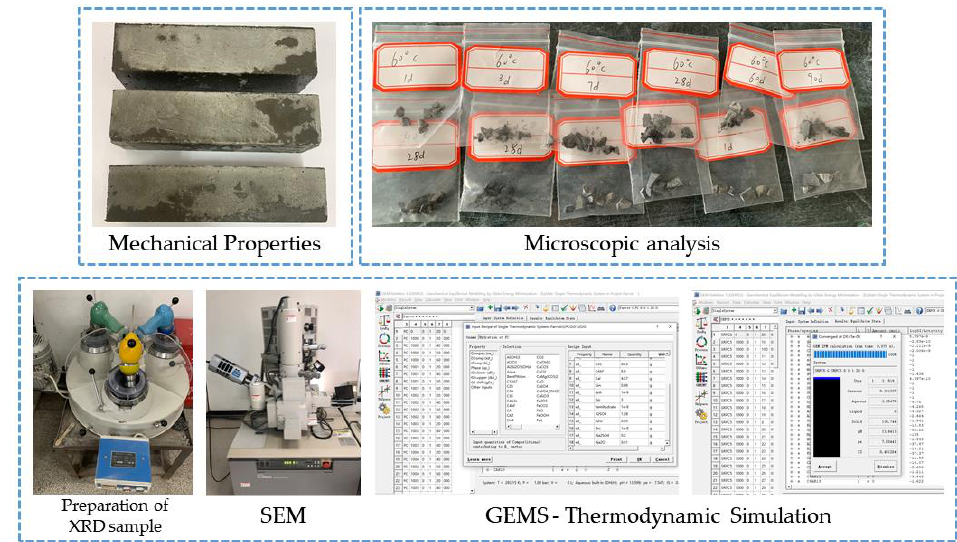
Figure 1. Preparation and testing stages.